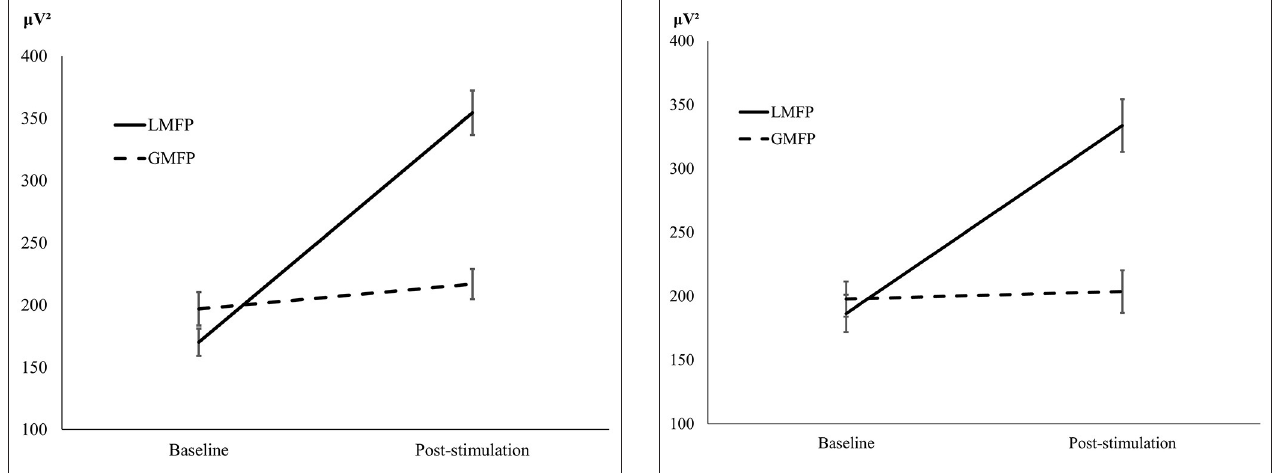
model. Full model results including covariates can be found in Supplementary Table 3